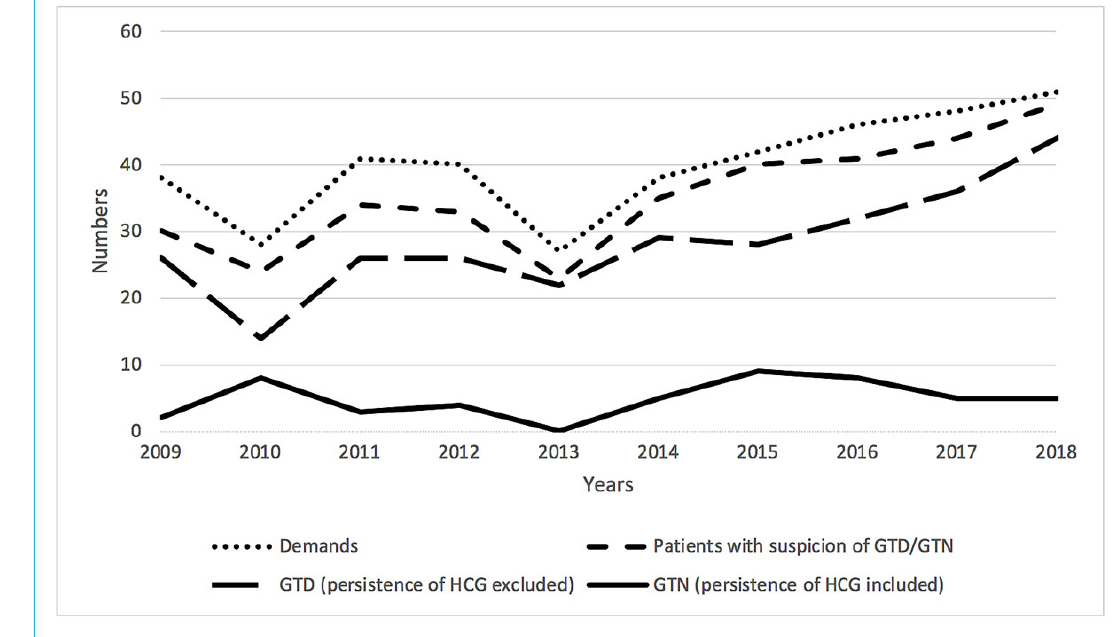
Figure 2: Evolution of recruitment. GTD = gestational trophoblastic disease; GTN = gestational trophoblastic neoplasia; HCG = human chori- onic